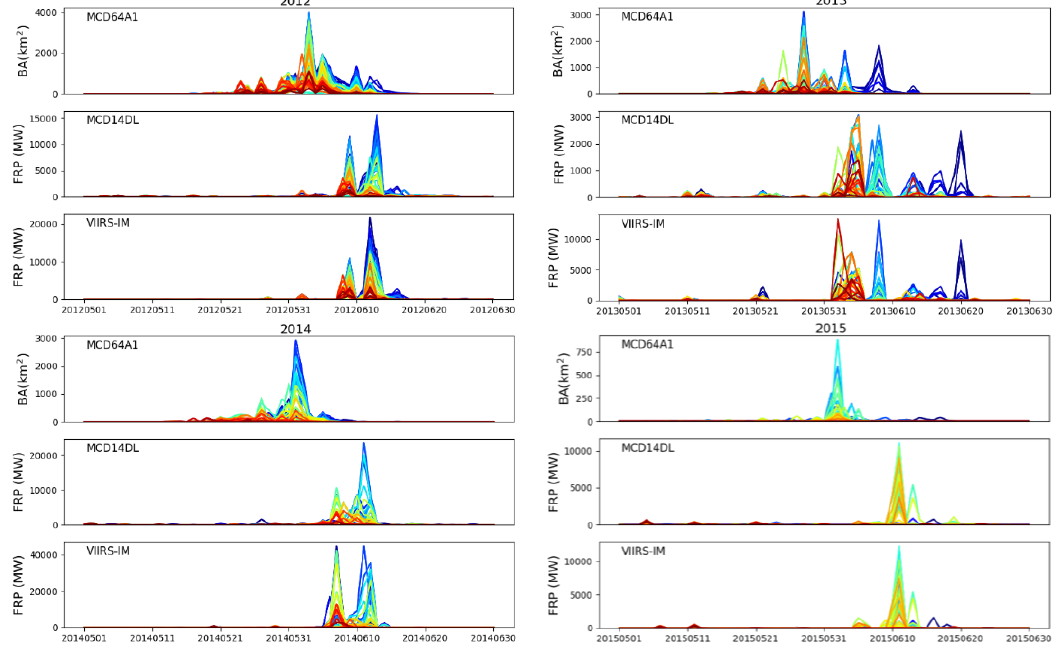
Figure 10. Time series of fire datasets for eastern China (region shown in Figure 1) during the summer burning season (May–June) from 2012–2015. The MODIS MCD64A1 product reports detected burned area (BA), and the MODIS MCD14DL and VIIRS-IM show retrieved fire radiative power (FRP) made at the locations of active fire (AF) detections. Colours represent different GFED grid cells within the region, and for clarity only those cells showing the fifty highest MCD64A1 burned area values are shown here. MCD64A1 reported burned area typically peaks 1 to 2 weeks before the AF products detect the peak in fire occurrence, suggesting that the BA product is identifying the initial harvesting of the crop rather than any subsequent burning of the crop residue left in the fields after harvest.